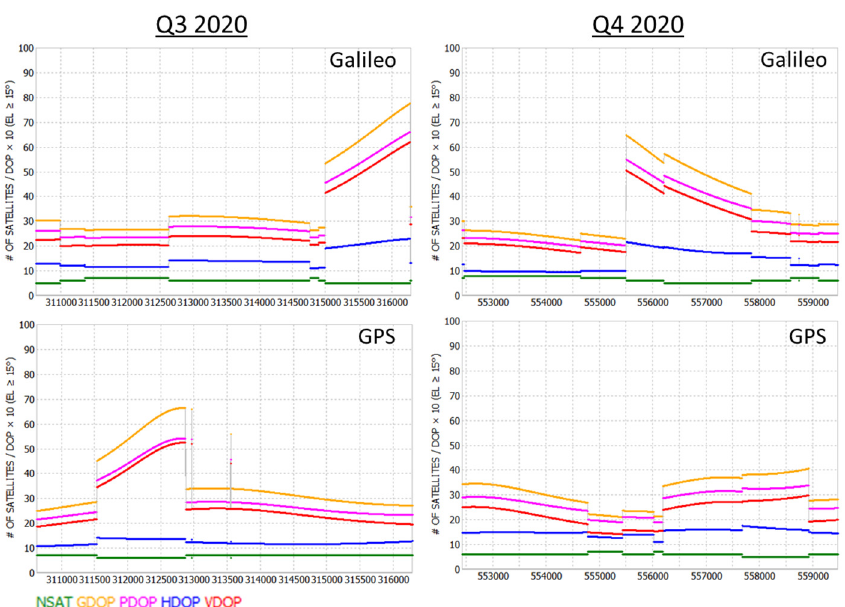
Figure 11. Satellite geometry for Galileo and GPS during the aerial four campaigns (values ×10). The green line indicates the total number of satellites in view.